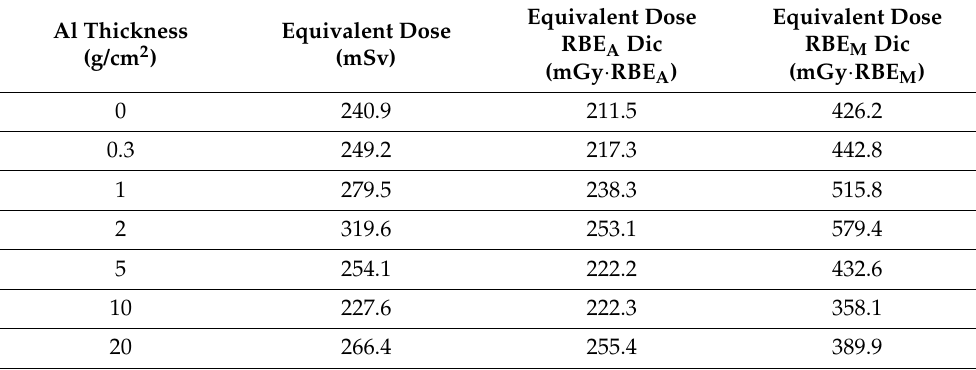
Table 7. Equivalent doses for 650 days in free space at solar maximum, calculated by multiplying the absorbed doses (in mGy) either by Q (column 2), by the dicentric RBE A , (column 3) or by the dicentric RBE M (column 4).